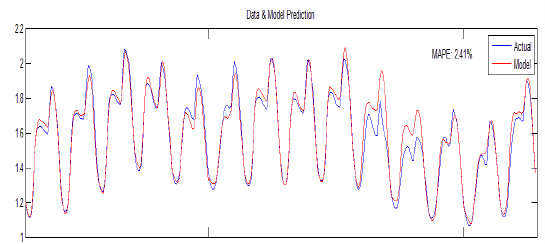
Fig. 8: ANN based Model and comparison with original